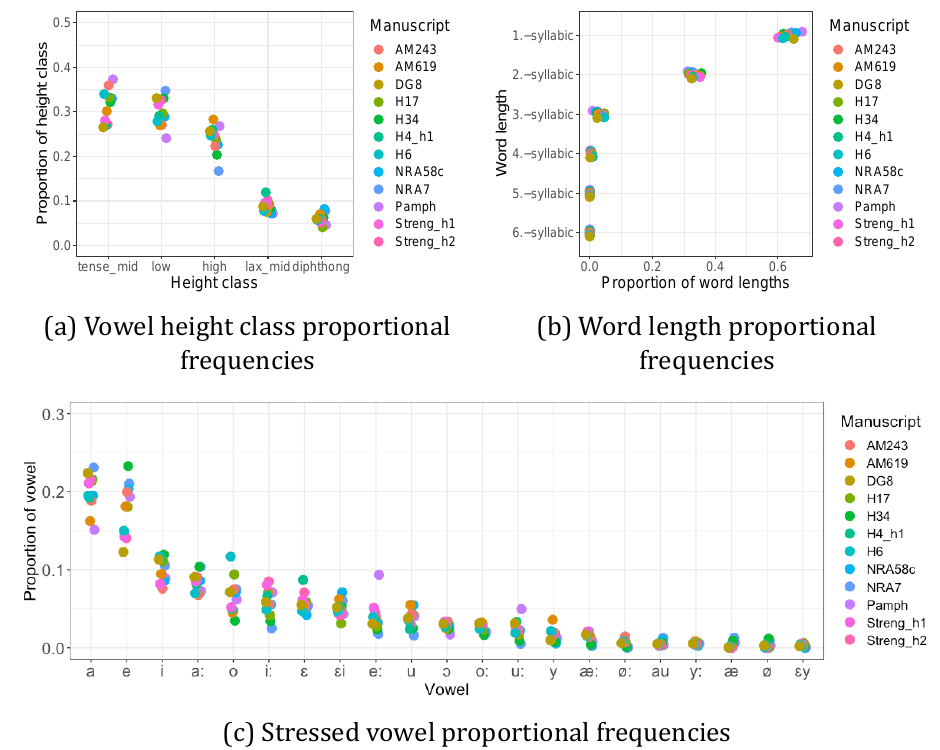
Figure 3: Consistent vowel, height class, and word length frequencies across